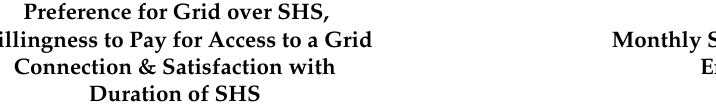
Table 8. Association between the preference for a stable grid connection to SHS, willingness to pay for one and the satisfaction with SHS duration, and monthly spend on non-cooking energy in Lagos State